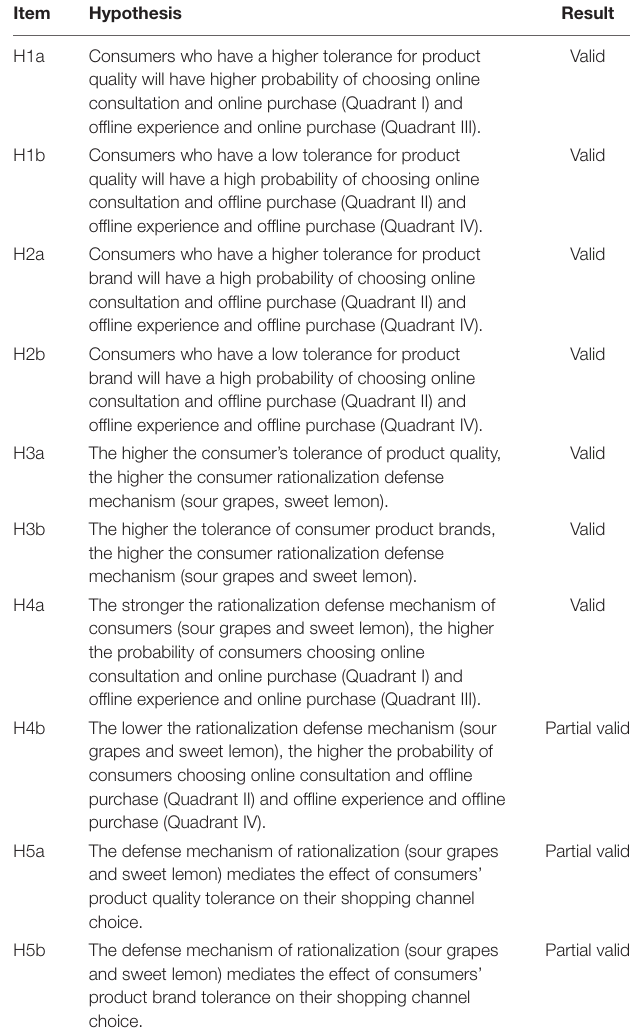
TABLE 5 | Summary of hypothesis